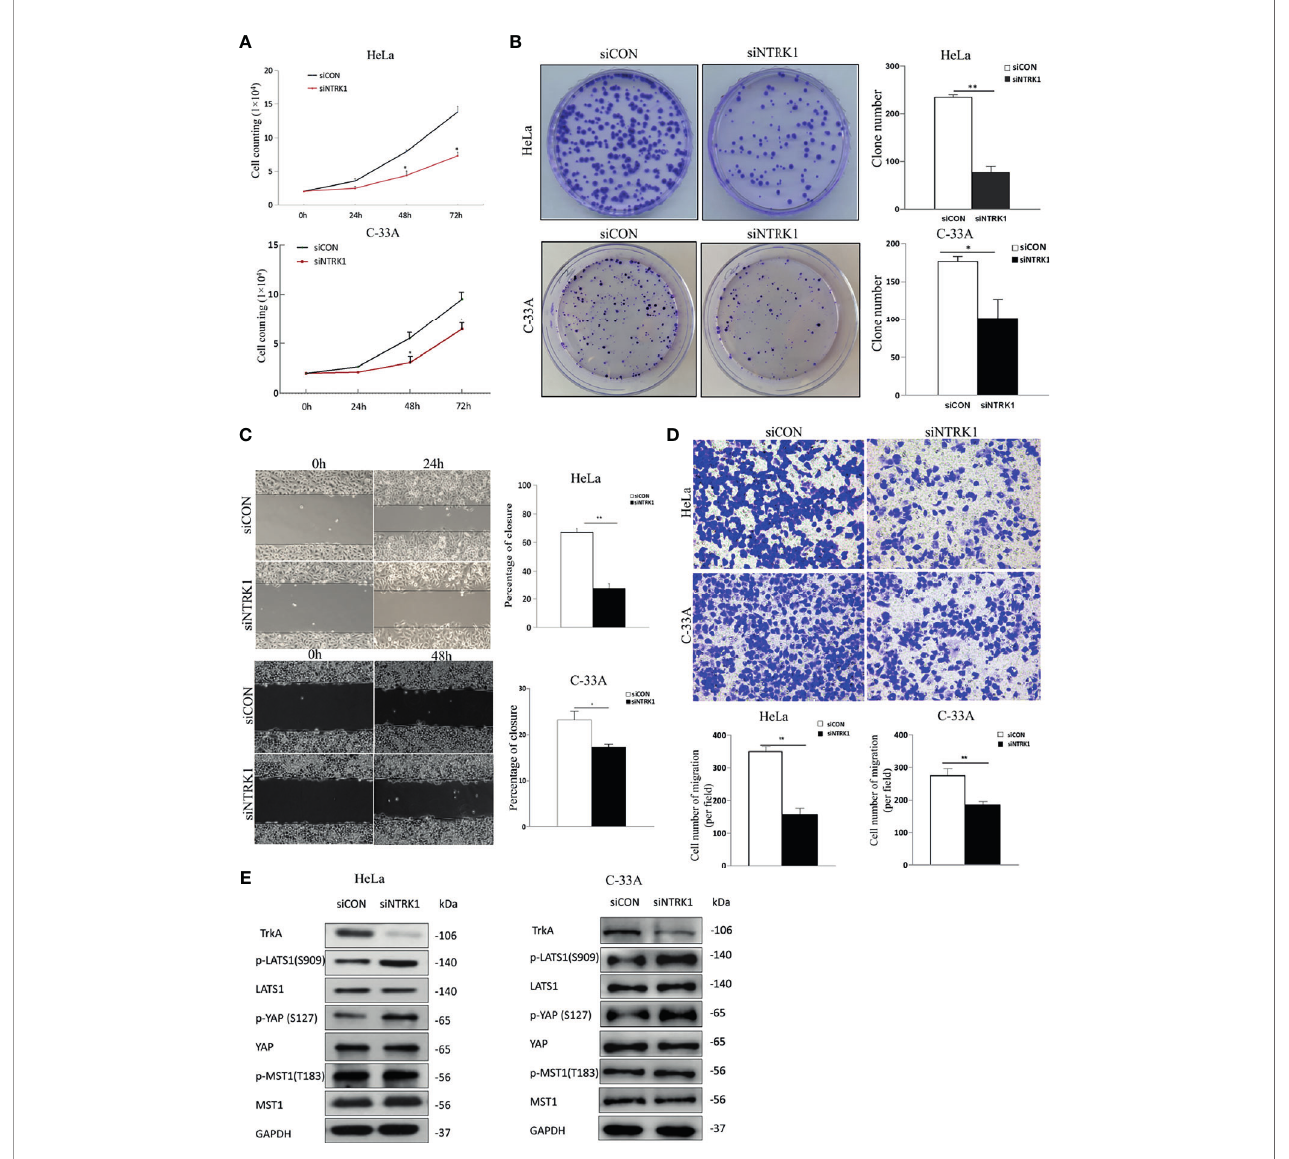
FIGURE 3 | Knockdown of TrkA suppresses cervical cancer cell line proliferation and migration. (A) The numbers of siCON or si NTRK1 -transfected HeLa and C- 33A cells were counted every 24 h for 72 h. (B) Representative images of a colony formation assay with siCON or si NTRK1 -transfected HeLa and C-33A cells after 3 weeks (left panel). The results of three independent colony formation assay experiments were quanti fi ed (right panel). (C) Representative images of a 24 h (HeLa cells) or 48 h (C-33A cells) wound healing assay with siCON or si NTRK1 -transfected cervical cancer cell lines (left panel). The extent of wound closure estimated from three independent experiments (right panel). (D) Representative images of transwell assays of cervical cancer cell lines treated with siCON or si NTRK1 -transfected cervical cancer cell lines (top panel). The extent of cell number of migration (per fi eld) estimated from three independent experiments was quanti fi ed (bottom panel). (E) Western blot analysis of lysates from siCON or siNTRK1-transfected HeLa and C-33A cells was performed with anti-TrkA, anti-LATS1, anti-p-LATS1, anti-YAP, anti-p-YAP (S127), anti-MST1, and anti-p-MST1 (T183) antibodies. GAPDH was used as a loading control. Error bars represent SDs; *P < 0.05, **P <